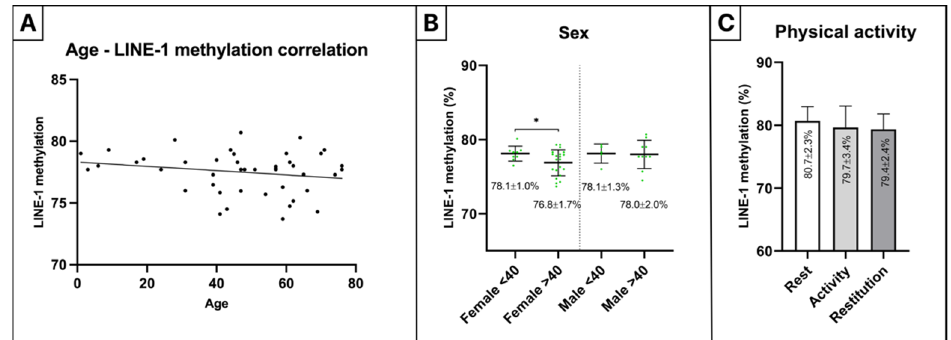
Figure 5. Analysis of LINE-1 methylation age and sex dependence in tissue, along with the impact of recent physical activity in plasma samples. No significant correlation was found between age and LINE-1 methylation ( ρ = − 0.18, p = 0.25) ( A ), and no significant LINE-1 methylation alteration was noticed between sexes ( B ) in tissue samples. ( B ) Significantly lower methylation of tissue specimens was detected in female patients older than 40 years old (76.8 ± 1.7%) in comparison with the sample group of female patients under 40 years (78.1 ± 1.0%) (* p ≤ 0.05). ( C ) Decreasing LINE-1 methylation was observed at the highest heart rate (79.7 ± 3.4%) during the exercise and following the physical activity (79.4 ± 2.4%) compared to the initial resting phase (80.7 ± 2.3%) in plasma samples.